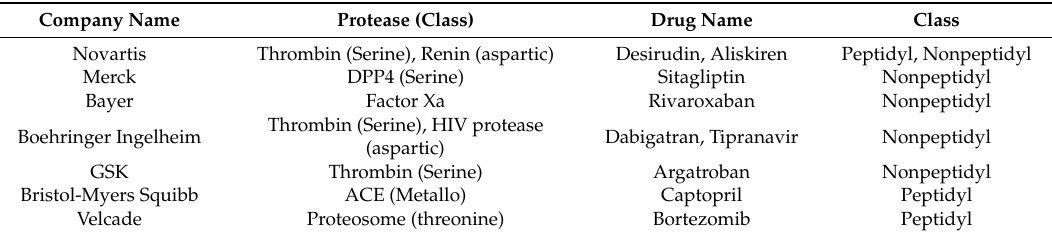
Table 1. Protease inhibitors in clinical use.